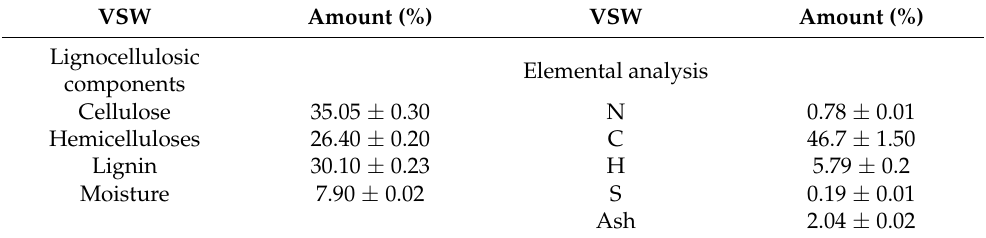
Table 1. Chemical composition (%) of the vine shoot waste (VSW) sample. VSW Amount (%) VSW Amount (%) Lignocellulosic